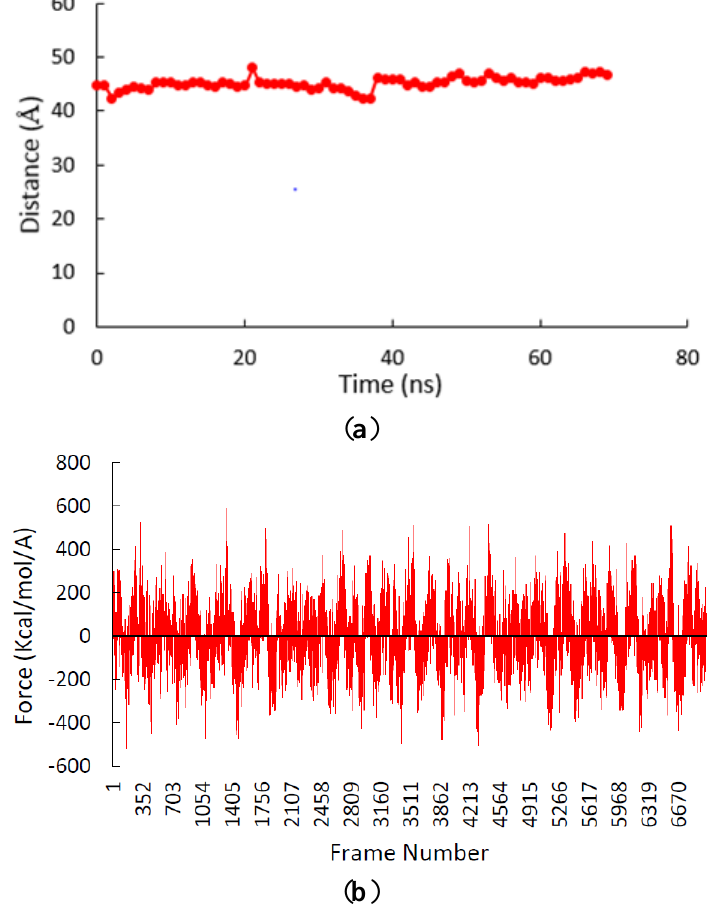
Figure 4. ( a ) Distance between the central of mass of the two α-subunit vs time in the CG SMD simulation. ( b ) Steered force of the CG SMD